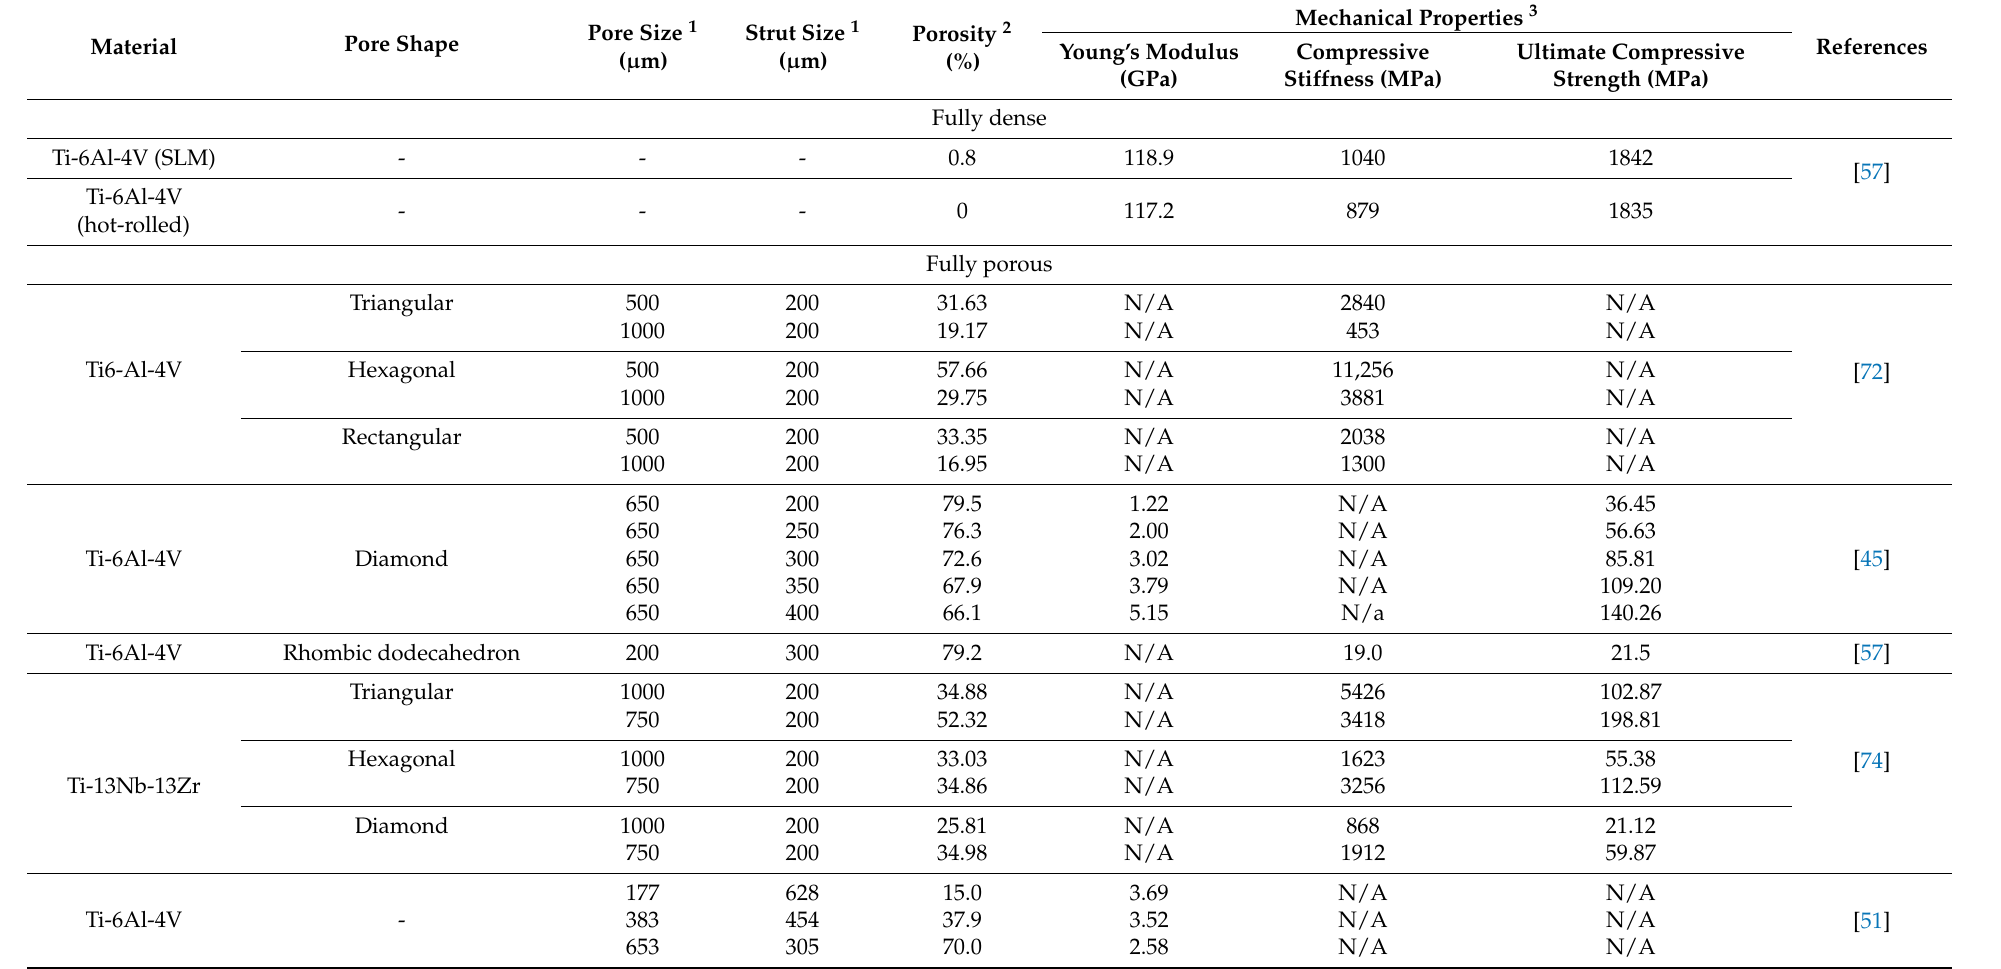
Table 6. Mechanical properties of porous Ti and its